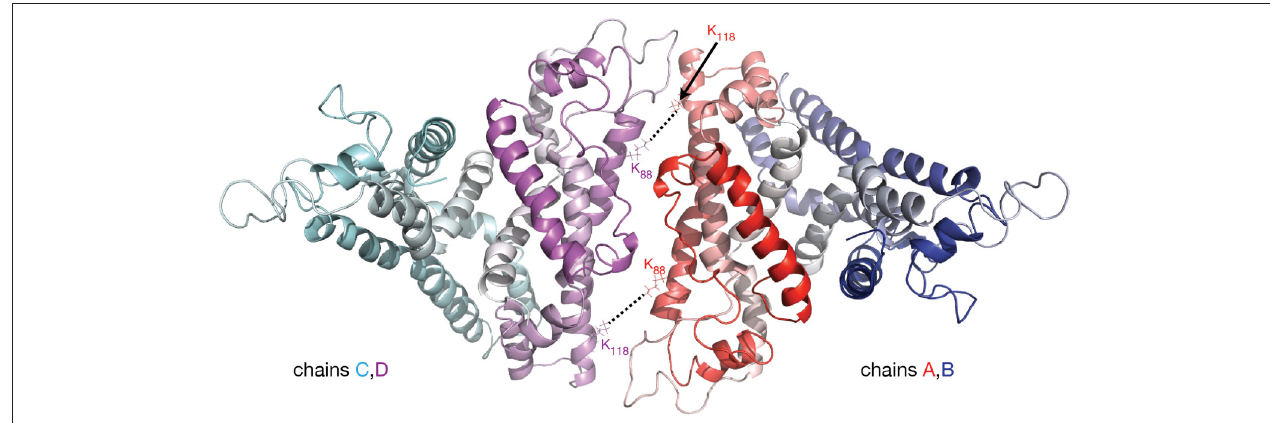
FIGURE 3 | Molecular model of lipid free apoA-I tetramer. The figure shows a cartoon representation of a lipid free apoA-I tetramer model constructed from two models of lipid free apoA-I dimer shown in Figure 2C , right (based on Segrest et al. lipid free apoA-I monomer, Figure 2C , left; Segrest et al., 2014). The protein chains are colored with gradient red/blue/cyan/magenta (N t is colored with solid color and C t with faded color). The K 88 –K 118 MS-crosslink reported by Pollard et al. (2013) at a concentration of apoA-I of 1mg/mL may come from a tetrameric state of apoA-I. In this hypothetical tetramer model of lipid free apoA-I, the distance between K 88A and K 118C is 10.6 Å and between K 88C and K 118A is 9.6 Å.